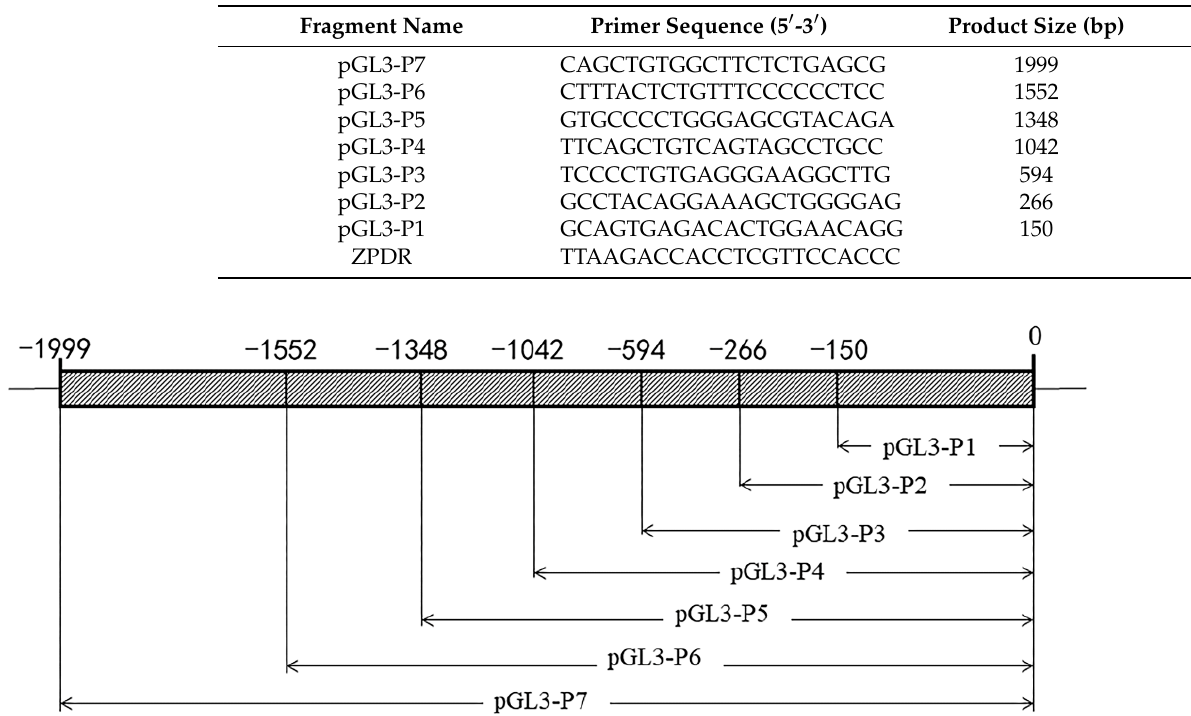
Figure 1. ZP2 gene deletion vector construction.